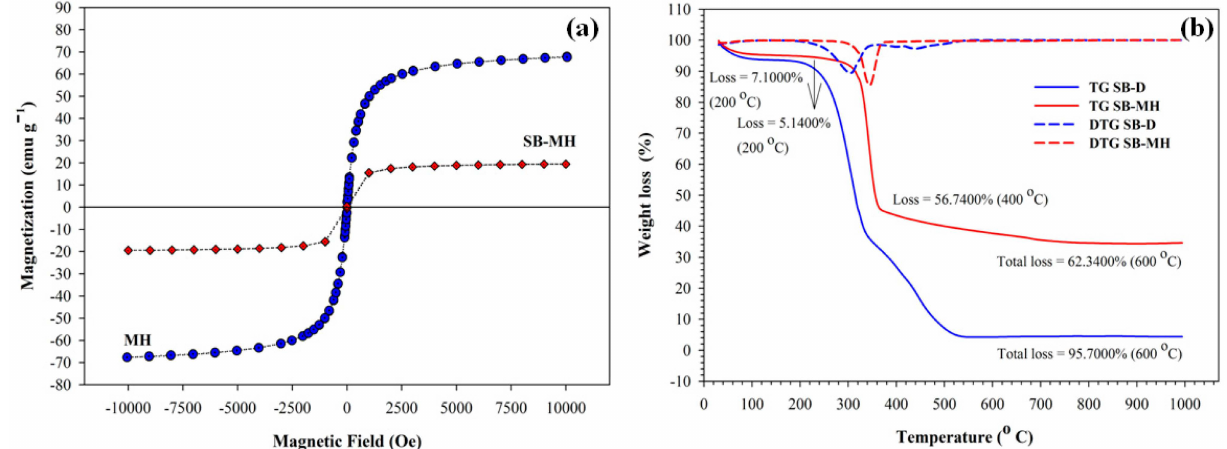
Figure 3. ( a ) Magnetization property of amine magnetic (MH) and amine magnetic sugarcane bagasse biocomposites (SB-MH) at room temperature; ( b ) Thermogravimetry (TG) and Derivative Thermogravimetry (DTG) curves of delignified sugar cane bagasse (SB-D) and amine magnetic sugarcane bagasse biocomposites